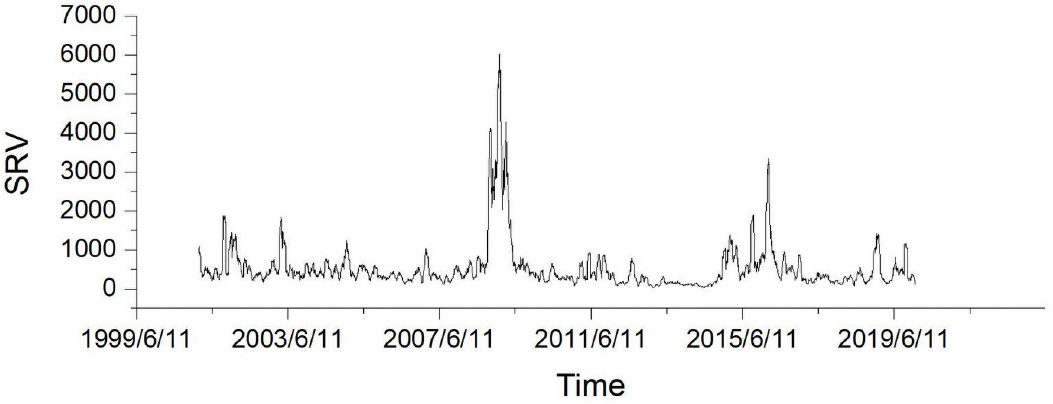
Fig 2. Daily simplified realized variance